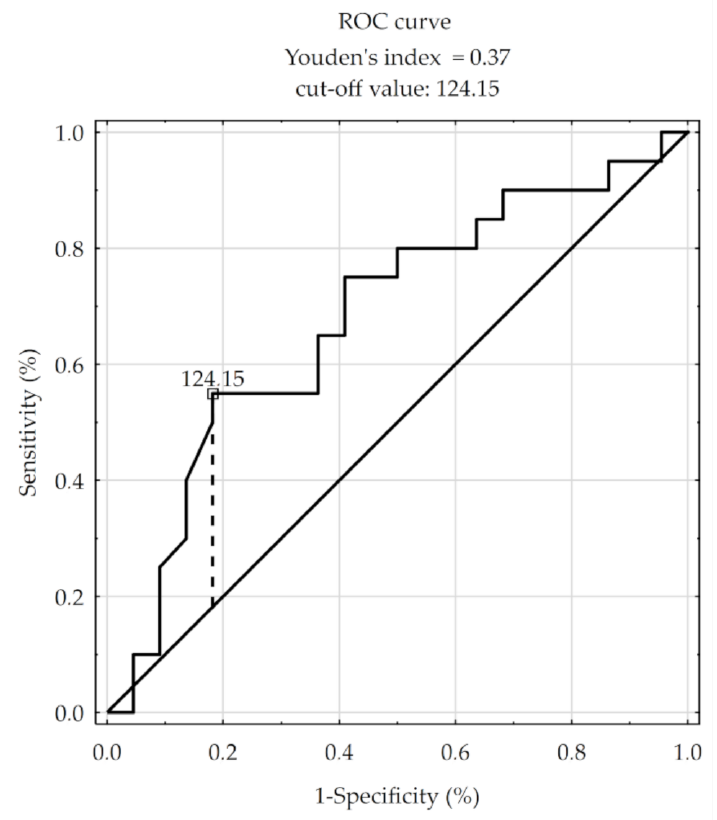
Figure 5. Receiver operating characteristic (ROC) curve for